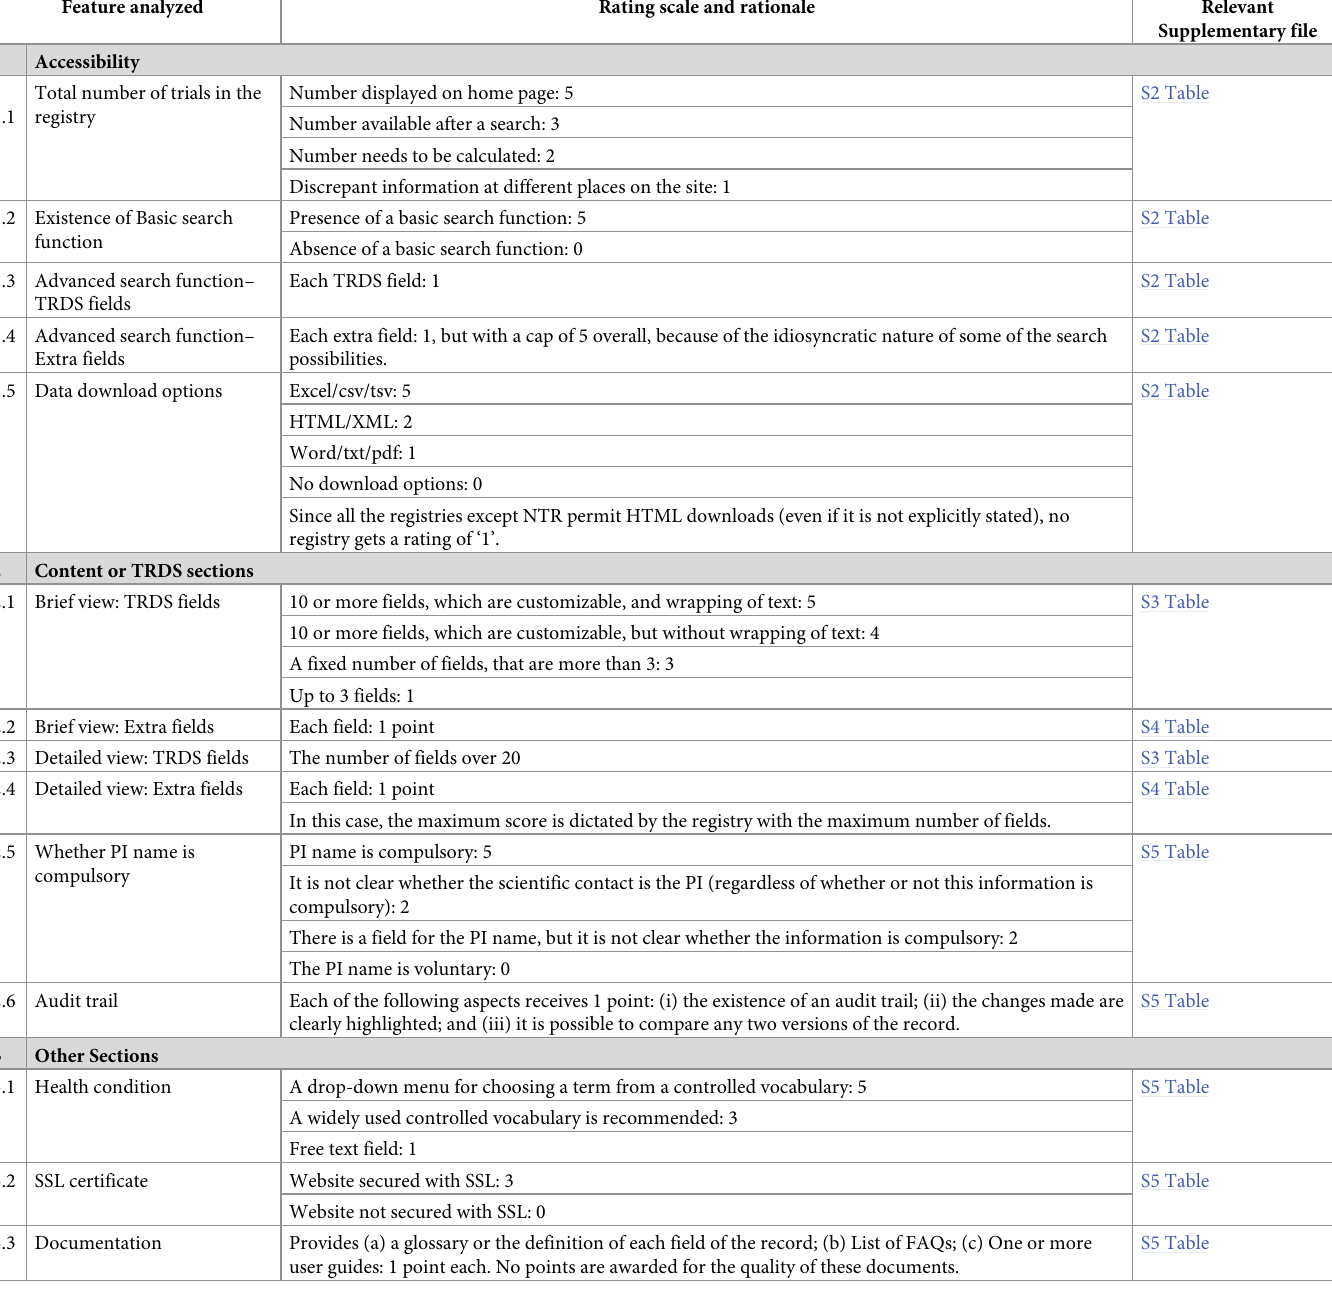
Table 1. Rationale for score given to each registry for features used to create the Scorecard. Feature